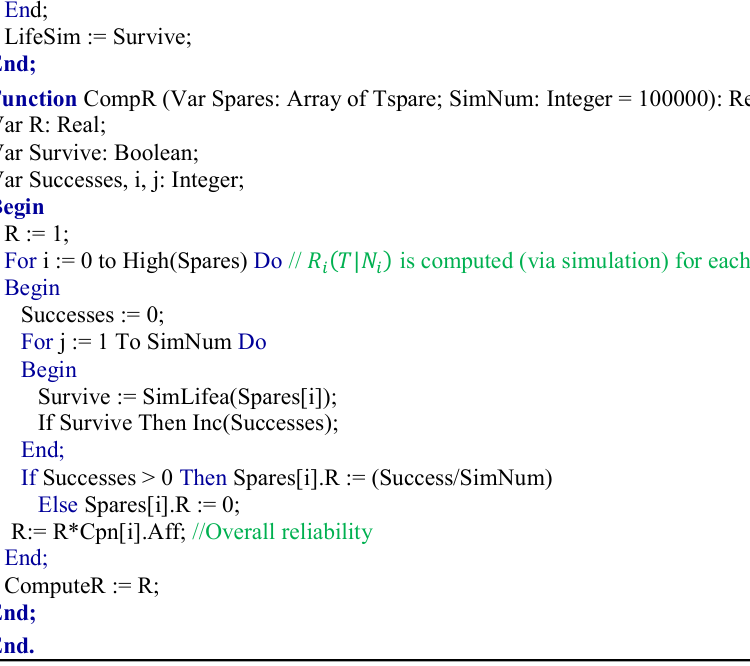
Fig. A.1. Reliability’s simulation pseudo